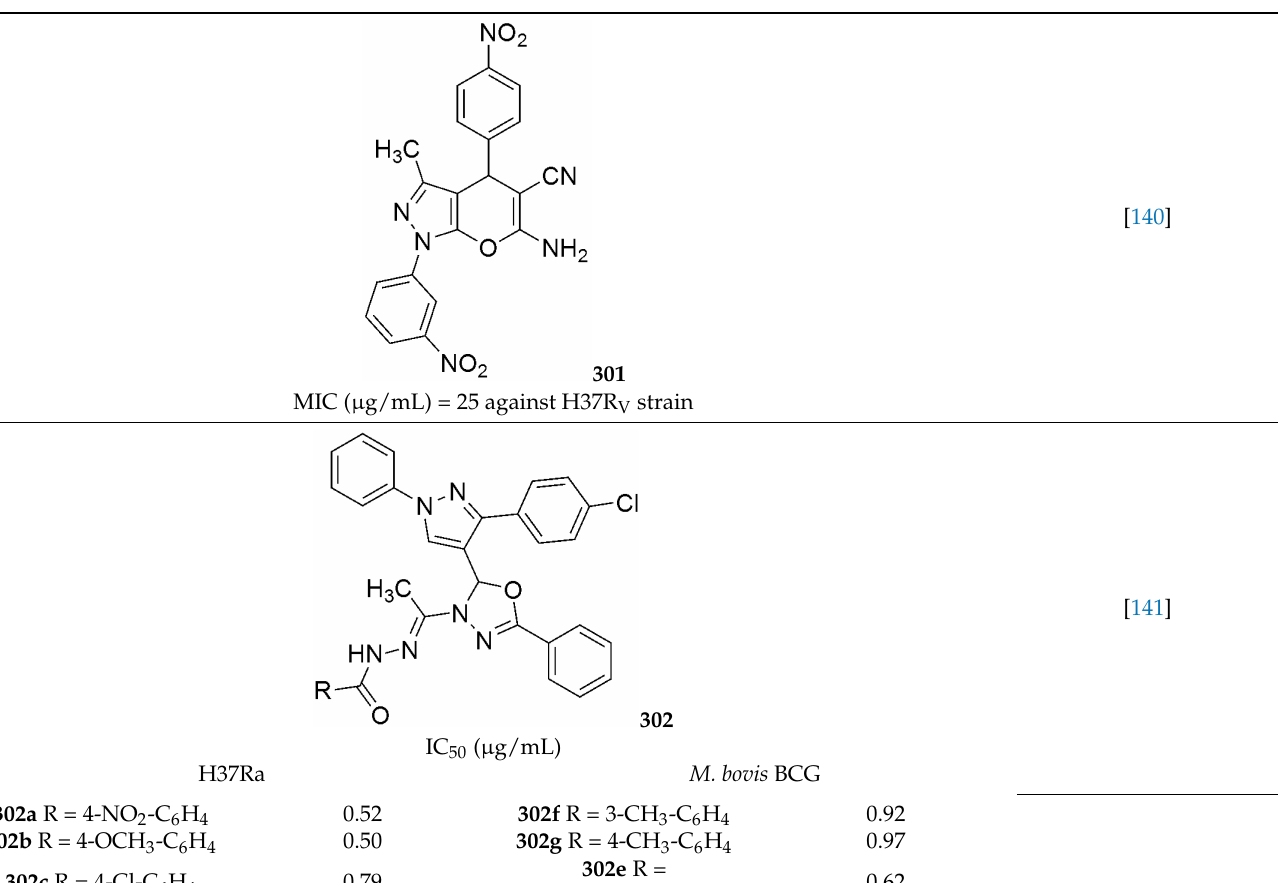
Table 1. Reported antituberculosis pyrazole derivatives, along with the corresponding